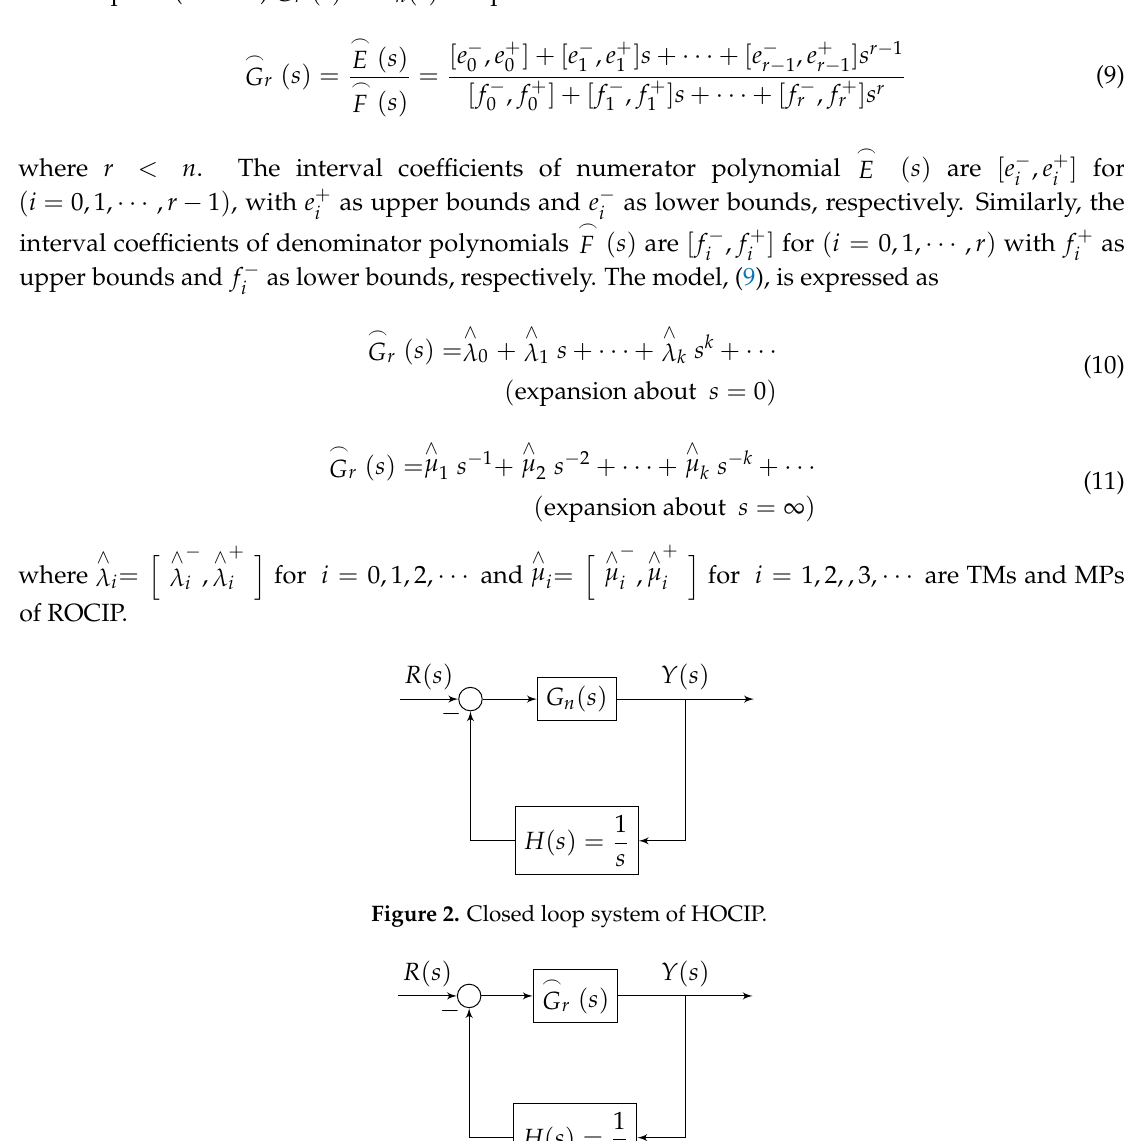
Figure 2: Closed-loop system of high-order continuous interval plant (HOCIP).